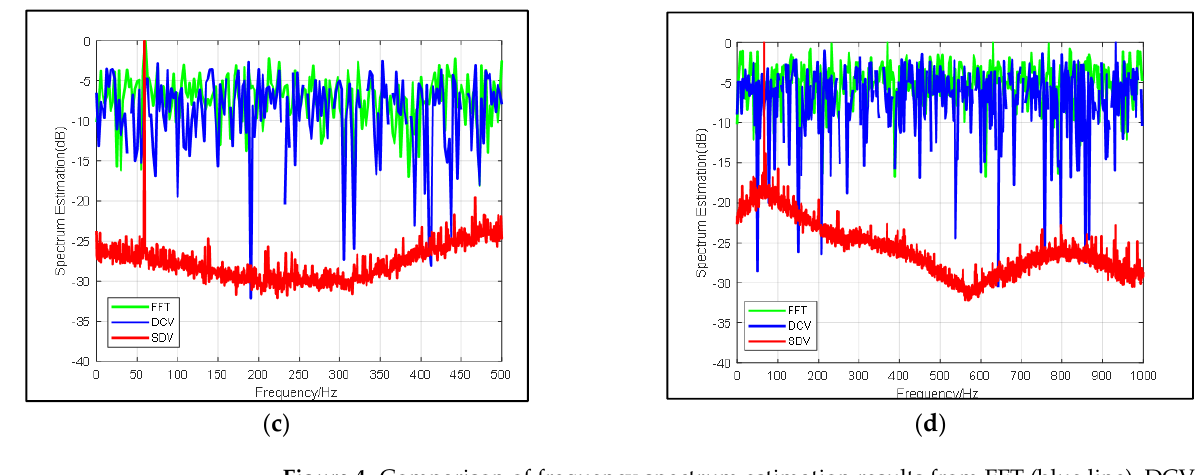
Figure 4. Comparison of frequency spectrum estimation results from FFT (blue line), DCV (green line) and SDV (red line) with same snapshots but different SNR: ( a ) SNR = − 20 dB, ( b ) SNR = − 22 dB, ( c ) SNR = − 24 dB, ( d ) SNR = − 26 dB.